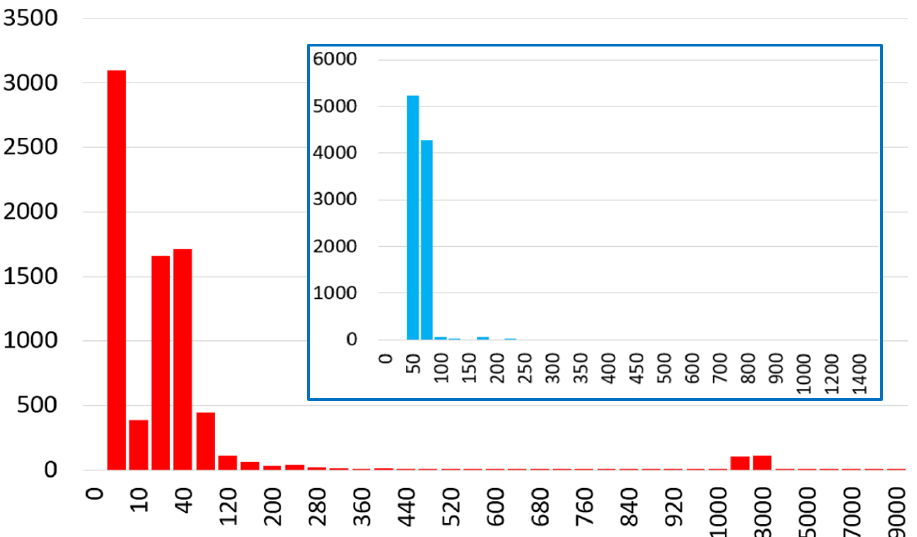
Figure 11. Downlink (red) and uplink (blue) traffic packet size distribution of APN “A1” (x axis: number of packets, y axis: Size of flows [Byte]).